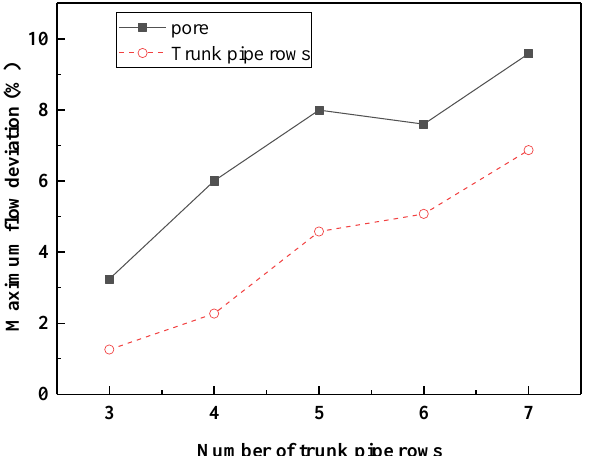
Figure 3. Maximum flow deviation for the water diffuser under different number of trunk pipe rows.